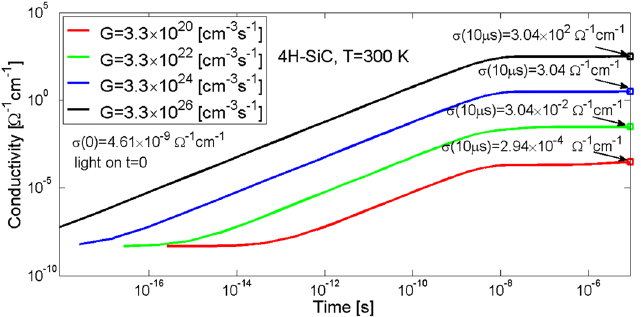
Figure 2. Simulation results of conductivity changes of 4H-SiC material. The changes, caused by photo-induced generation of electron–hole pairs, are shown here for various values of laser light power given as the generation rate coefficient G.